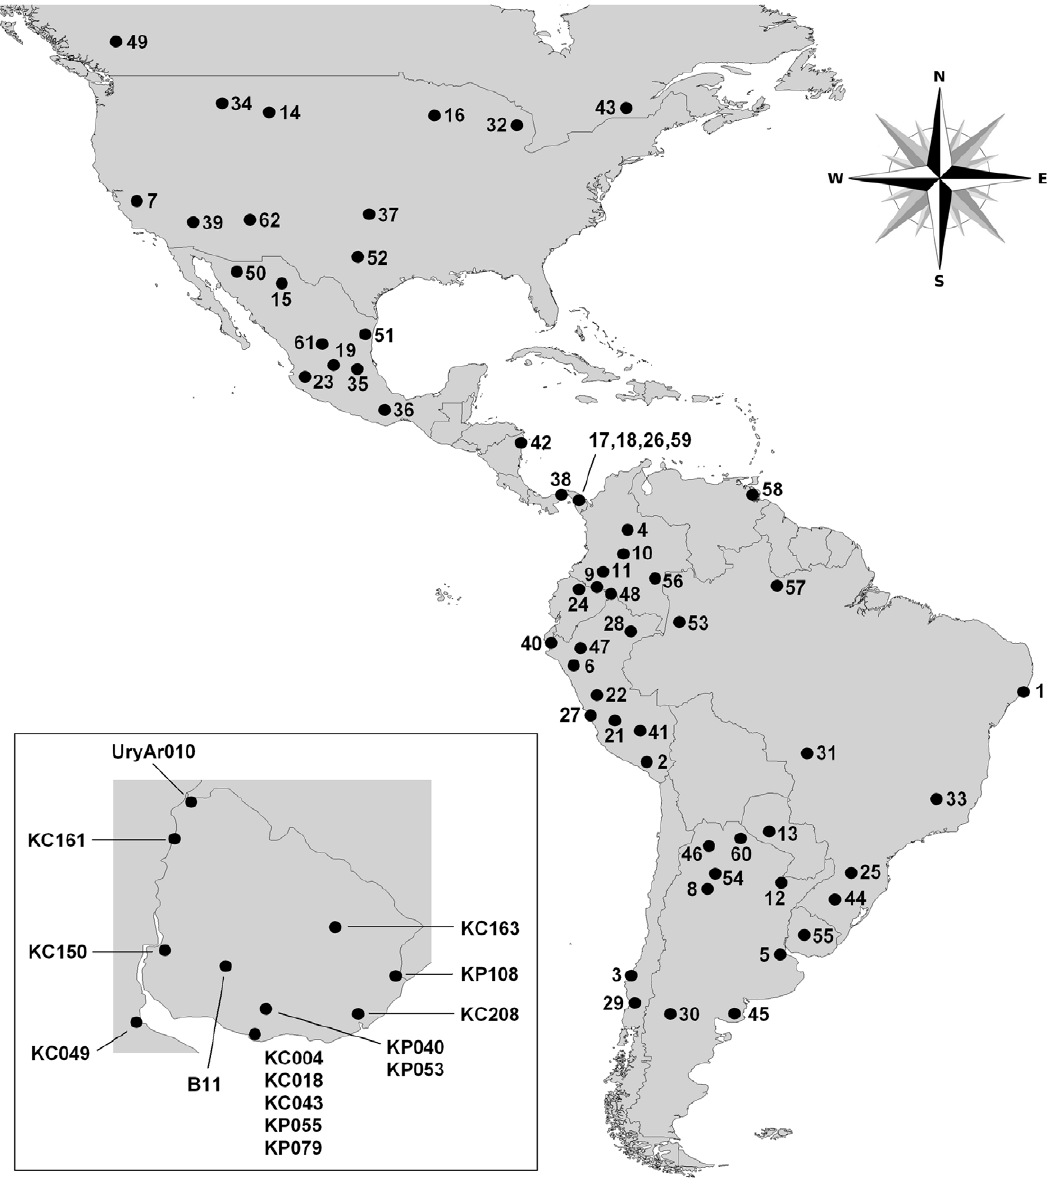
Figure 1. Geographic location of the populations carrying haplogroup C1d. The numbers correspond to those found in Table S1. Inset: Birthplaces of the individuals whose sequences were obtained in this study (see Table 1 for details).